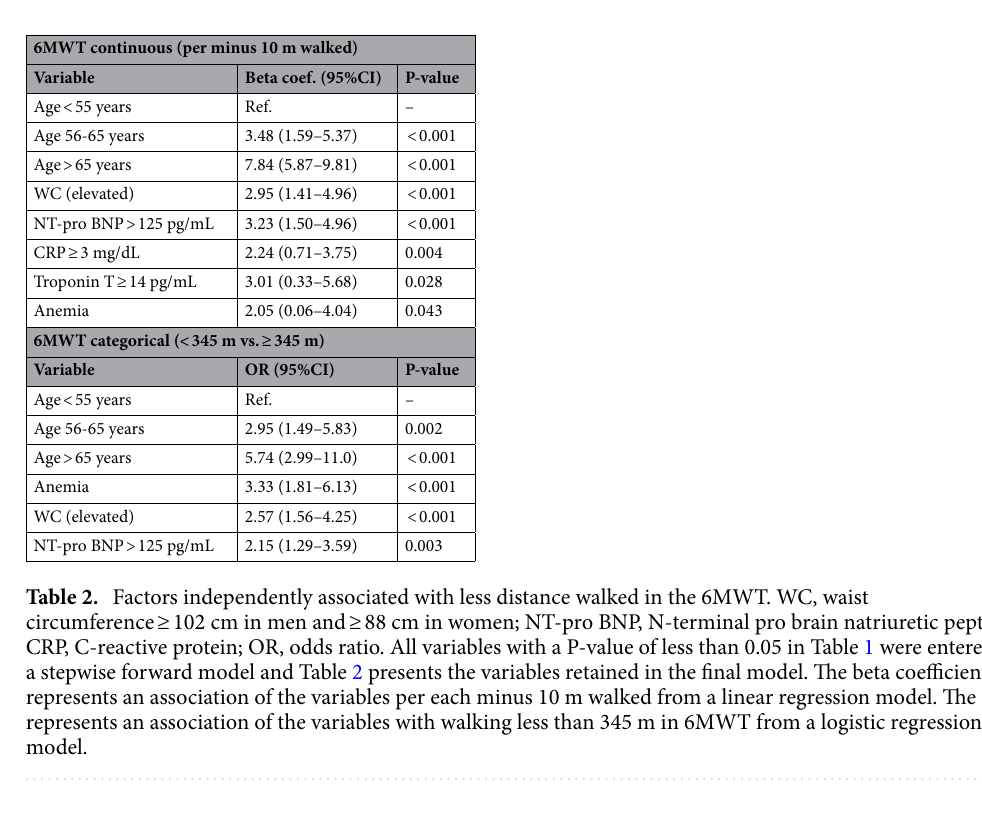
HR (95%CI) P-valueEvents, n (%) Events, n